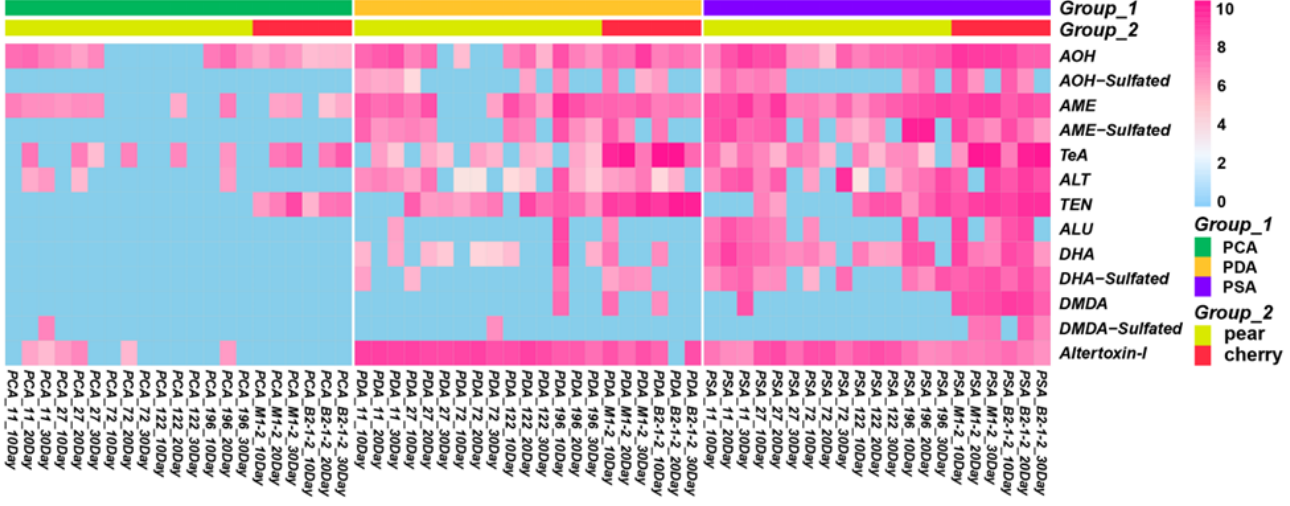
Figure 4. Heatmap for free Alternaria mycotoxins and sulfated mycotoxins by Alternaria fungi cultured in PCA, PDA and PSA medium.